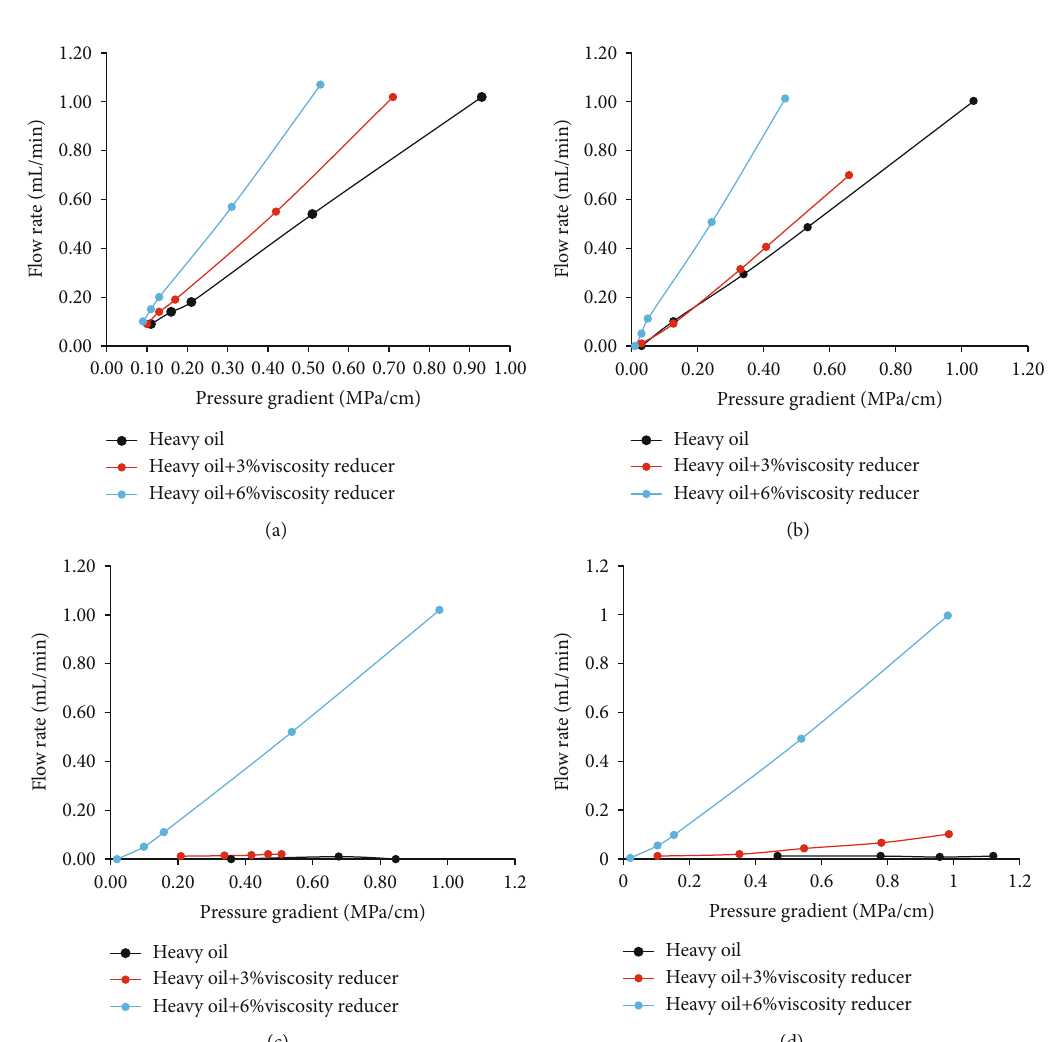
Figure 5: The relationship between fl ow rate and pressure gradient: (a) represent core fl ooding with 145mD and 150 ° C; (b) represent core fl ooding with 40mD and 150 ° C; (c) represent core fl ooding with 145mD and 76 ° C; (d) represent core fl ooding with 40 mD and 76 °